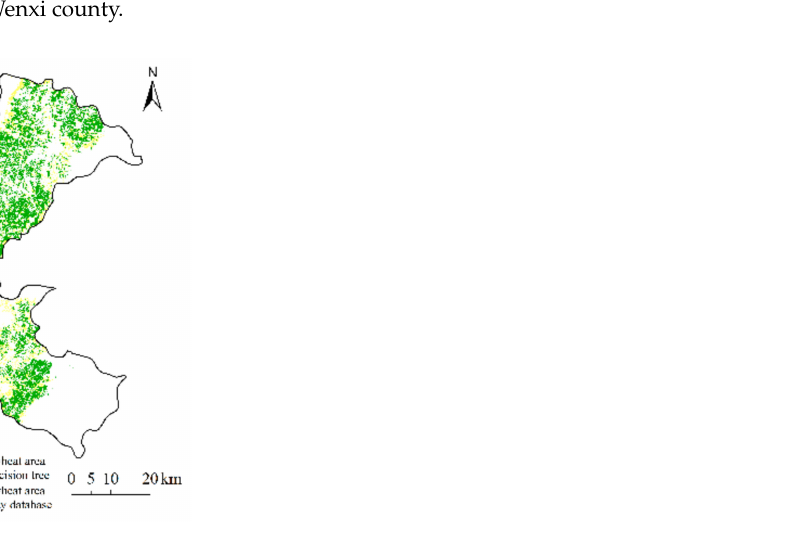
Figure 3. The irrigated winter wheat area extracted from the decision tree and the irrigated winter wheat area of the farmland fertility database of Shanxi Province in